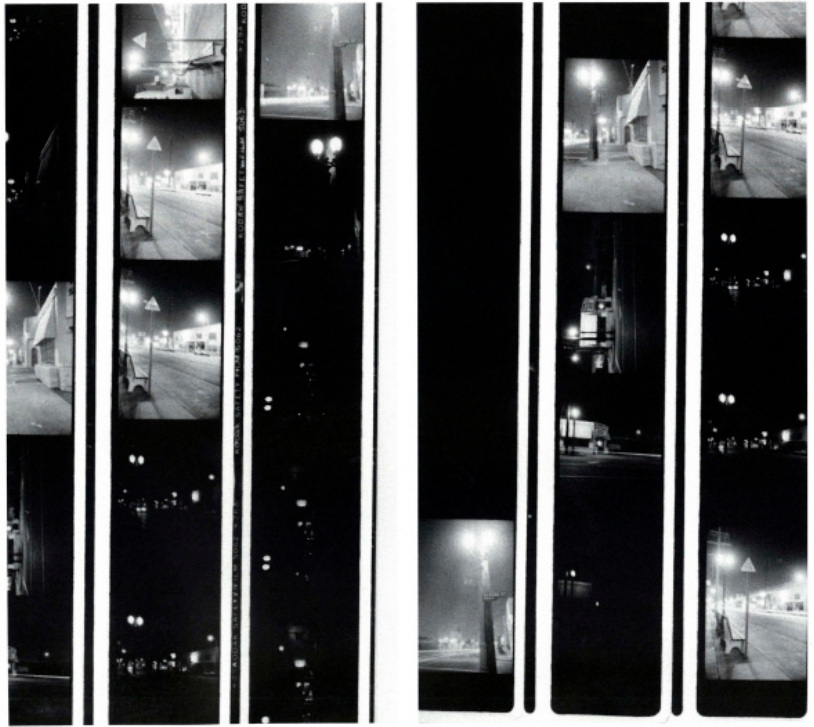
Figure 21. John Duncan, Every Woman , 1978, performance in the streets of Hollywood, Los Angeles.